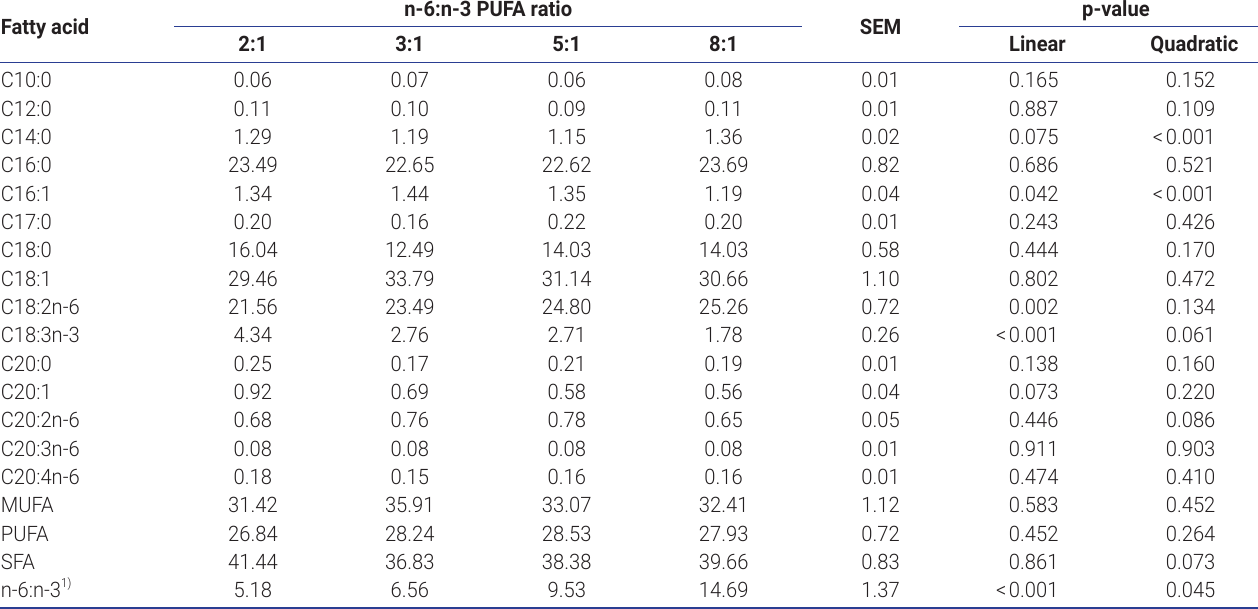
Table 7. Effects of dietary n-6:n-3 PUFA ratios on fatty acid composition of the SCAT of pigs (% total fatty acids)